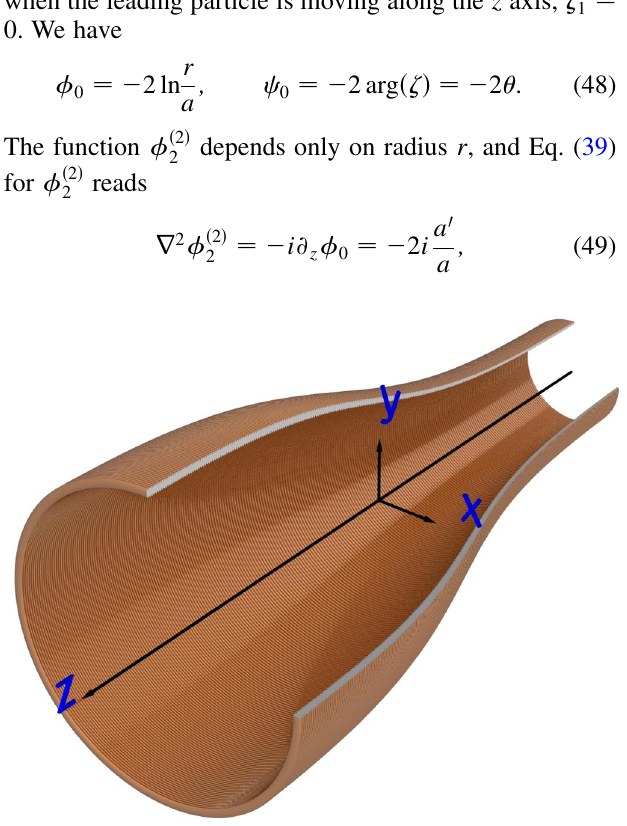
FIG. 2. (Color) Geometry of a round